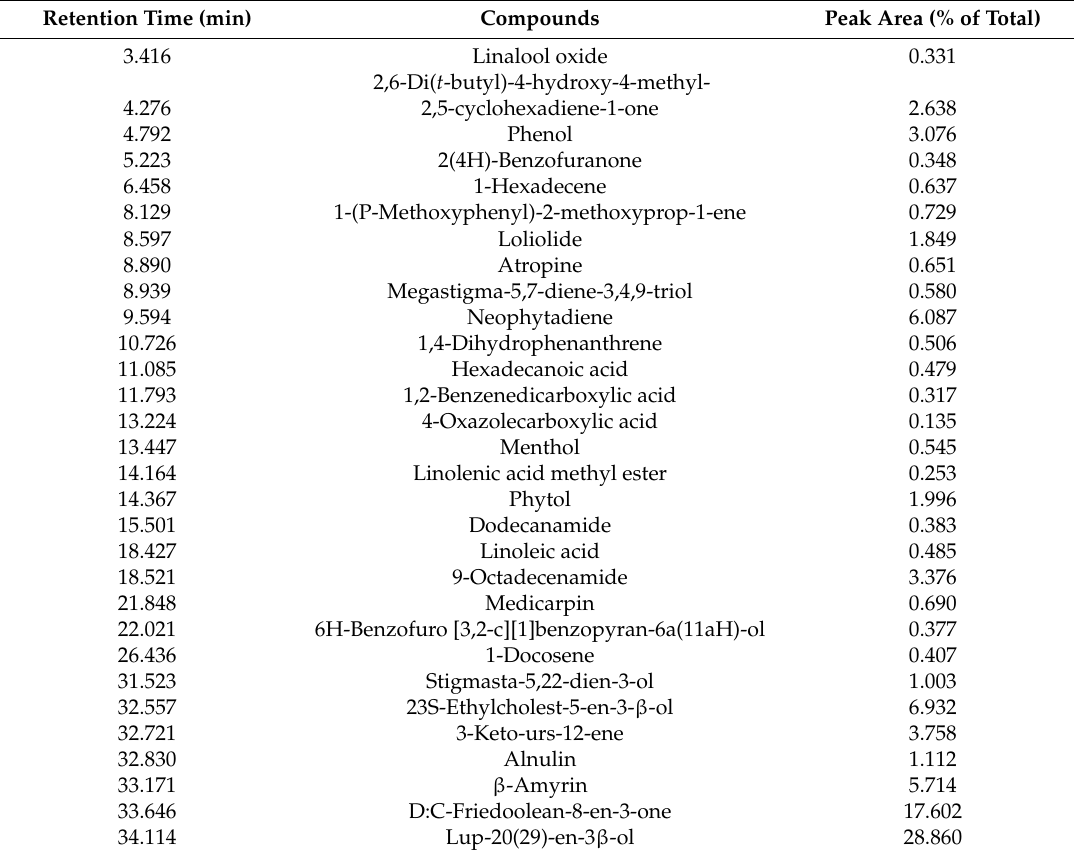
Table 4. Phytocomponents identified in the Fraction 2 (diethyl ether) of J. paniculata leaves by GC-MS. Retention Time